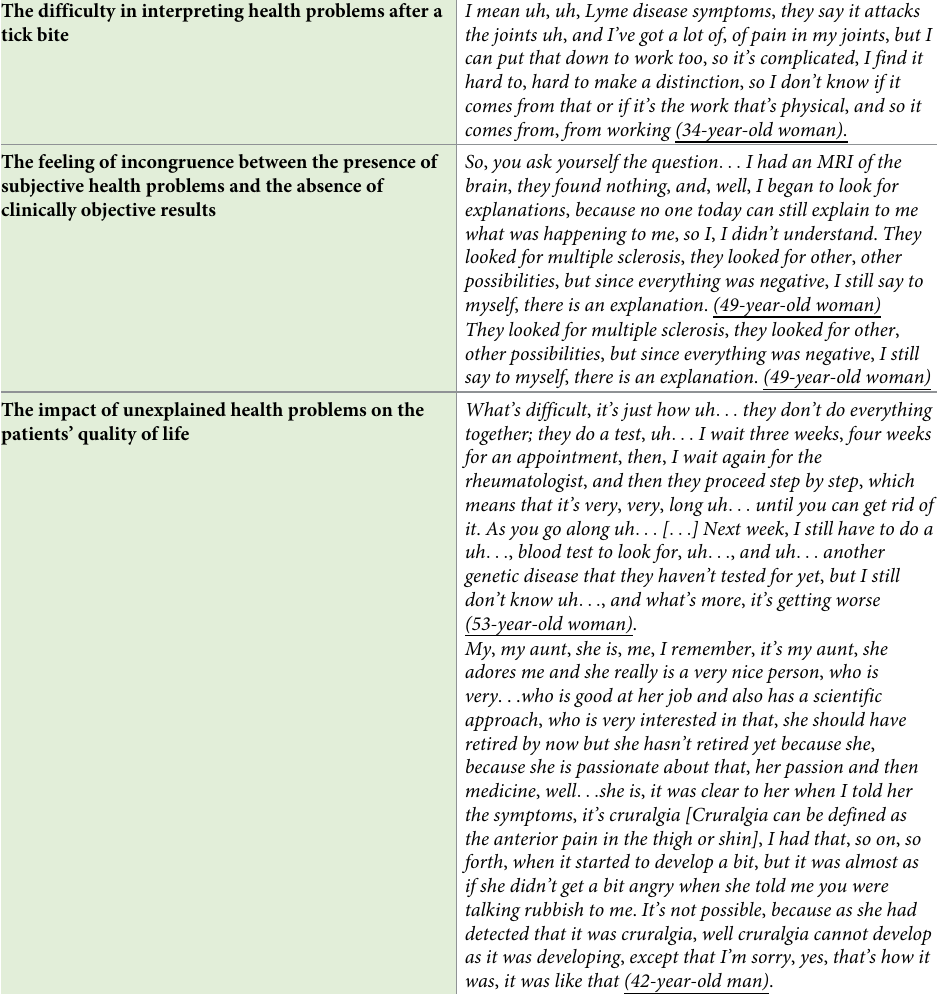
Table 3. The experience of